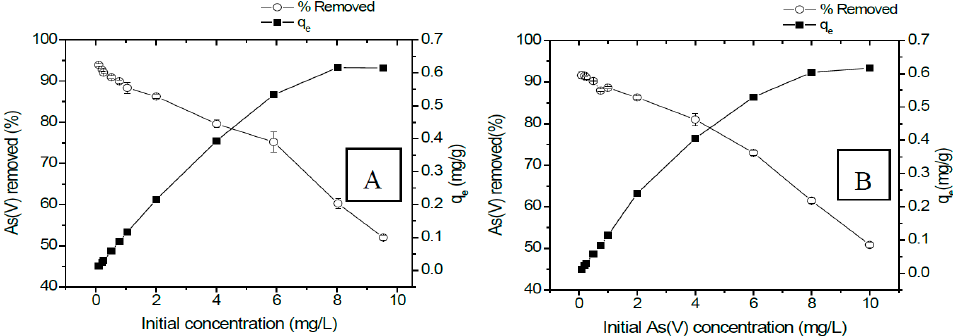
Figure 9. As (V) removed (%) and adsorption capacity equilibrium (mg/g) as function of initial concentration of As(V): ( A ) Ch–Rs ( B ) Ch–Pu blends (adsorbent dose 8 g/L, initial pH 7, shaking 2 h at 200 rpm at 24 ± 1 °C).